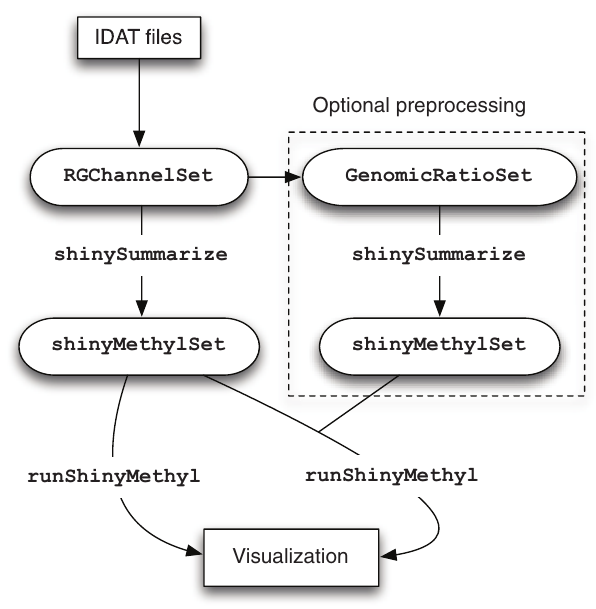
Figure 1. The workflow of shinyMethyl . IDAT files are parsed using minfi and illuminaio into a RGChannelSet . This object is summarized using shinySummarize . Optionally, the data are pre-processed and the pre-processed data are summarized. For visualization, runShinyMethyl is used on either one or two sets of summarized